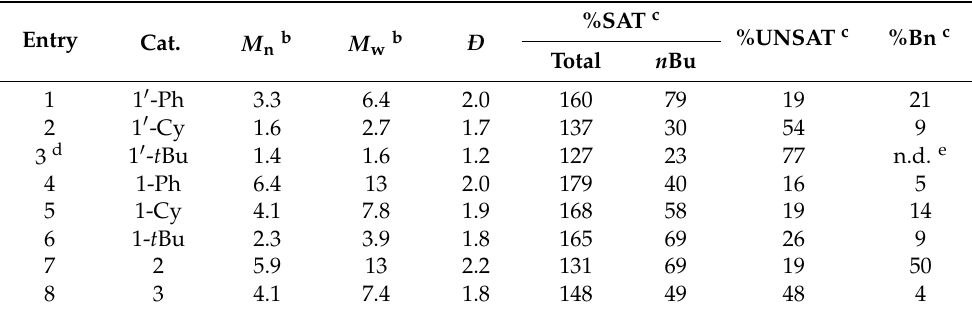
Table 1. Summary of some microstructural parameters of polypropylene samples obtained with catalysts 1 – 3 a .